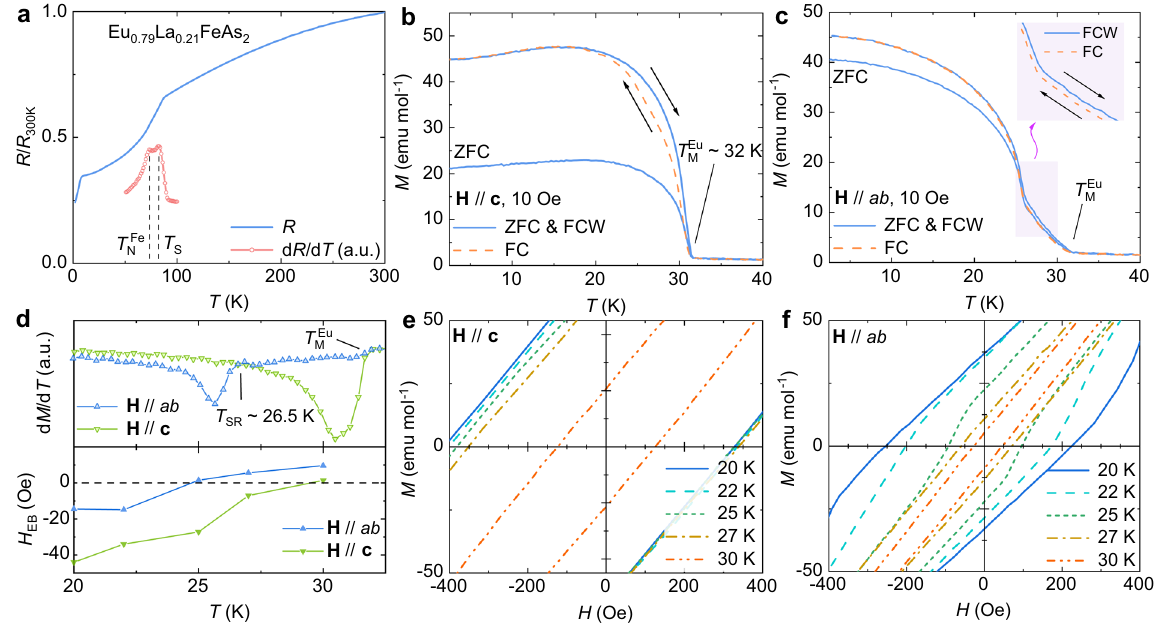
Fig. 2 Physical properties of Eu 0.79 La 0.21 FeAs 2 . a Normalized in-plane resistivity against temperature with part of the fi rst derivation curve. b , c Magnetization against temperature with magnetic fi elds parallel to different directions. d First derivation of the M – T curves (10 Oe) and the EB fi elds in different directions. e , f Magnetization against the fi eld in different directions. The inset in c is the enlarged view of the thermal hysteresis of the FC and FCW curves in the shadow